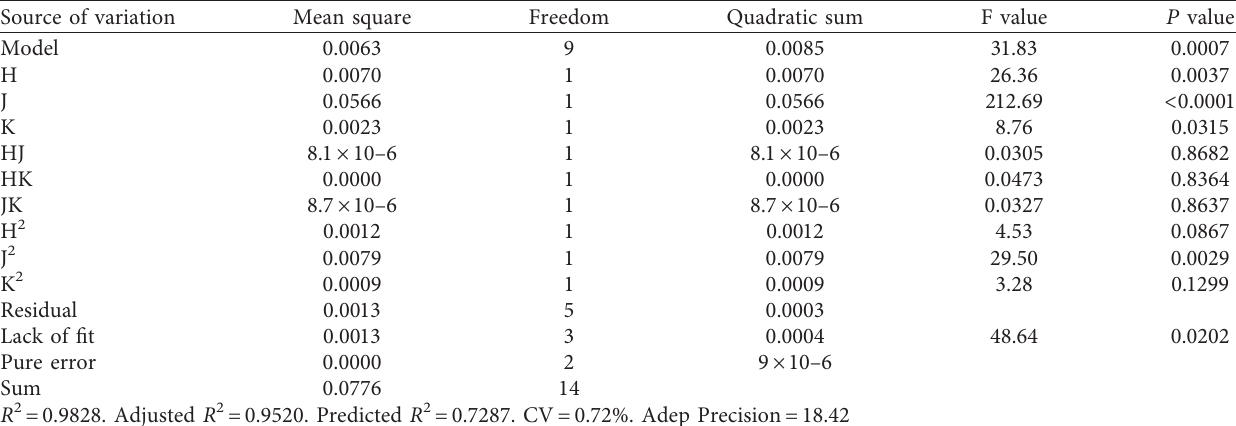
Table 7: ANOVA of quadratic polynomial model of Box-Behnken experiment.